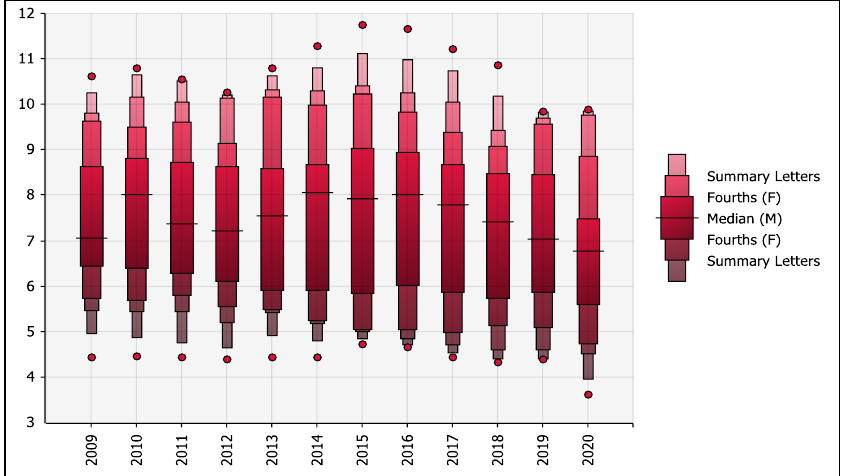
Figure 3. Letter value plot for the share of environmental tax revenues in the total tax revenues of the EU27 in 2009 – 2020 (source: own study). The share of environmental tax revenues in total tax revenues decreased in 19 coun- tries in the analyzed period by an average of 1.39 pp. This ratio increased in the remaining 8 countries by an average of 0.73 pp. The highest share of environmental tax revenues in total tax revenues, measured by the weighted average, was observed for Latvia and Bul- garia at the level of 10.69% and 9.84%, respectively. In Latvia, it increased by 0.2 pp, and in Bulgaria, it fell by 0.73 pp. The highest increase in the ratio was observed in Greece from 6.77 to 9.69%, which took 3rd place in the ranking. The lowest level of the weighted average level of the share of environmental tax revenues in total tax revenues was ob- served in the research conducted for Luxembourg and Germany. It was 4.75% and 4.78%, respectively. In Luxembourg, it dropped by 2.93 pp (the largest decrease in the discussed group of countries) in the analyzed period, and in Germany by 1.58 pp. It should be noted that the difference between the largest and the smallest weighted average share of envi- ronmental tax revenues in total tax revenues was 5.94 pp in the studied group of countries. This indicates a large variation in the size of the ratio in question in the Member States of the European Union because, in the country with the highest ratio, it was more than twice as high as in the country with the lowest. A detailed ranking of countries is presented in Table 2.